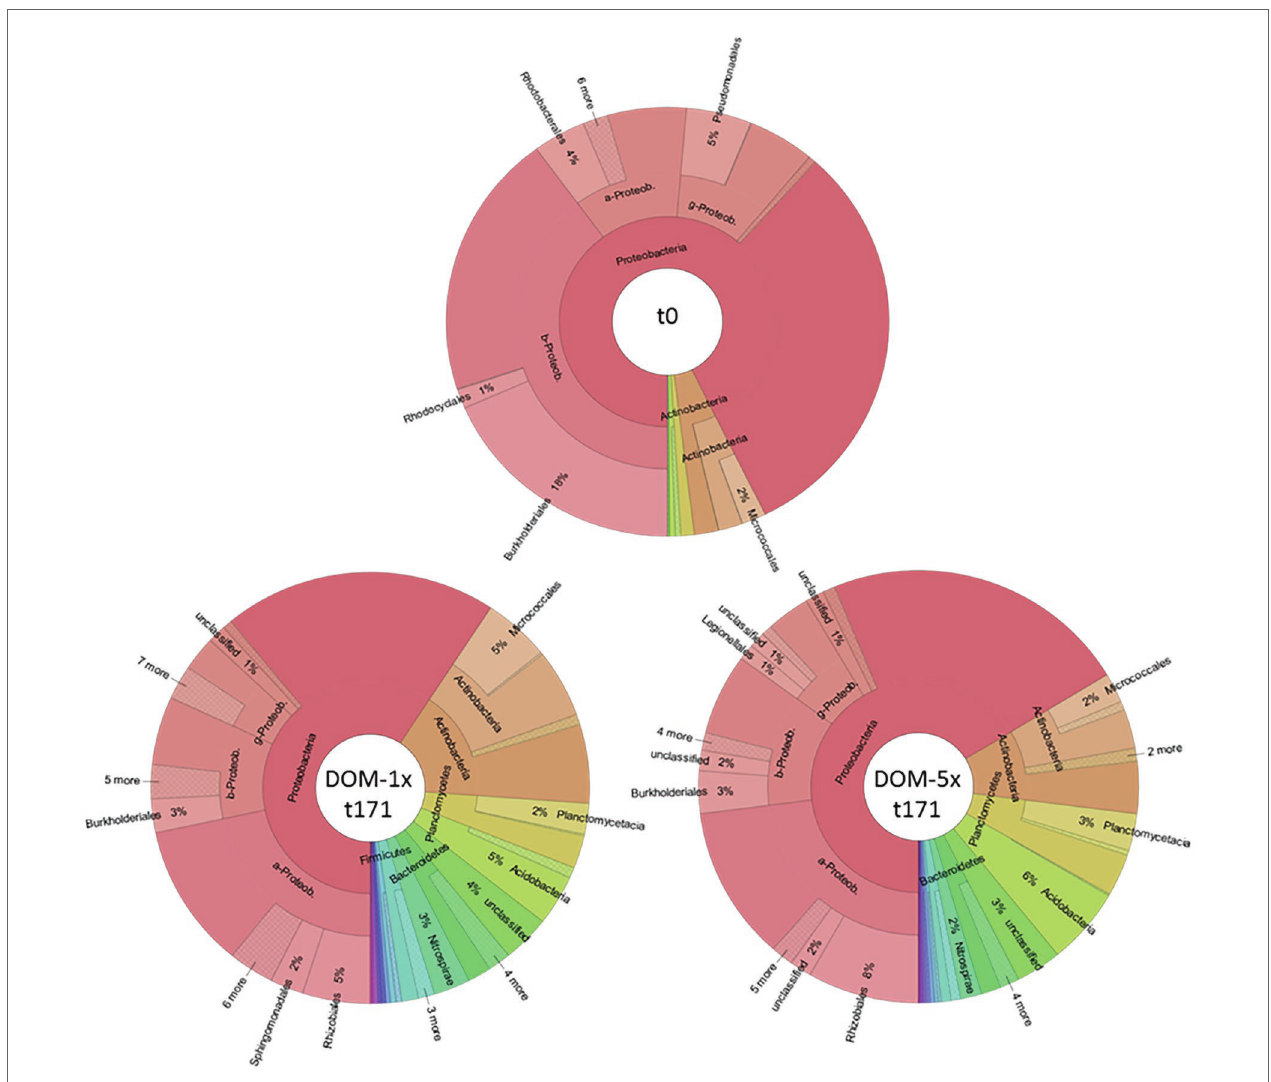
FIGURE 8 | Bacterial community composition in fresh aquifer sediment and in the sediments receiving DOM-1x and DOM-5x for 171